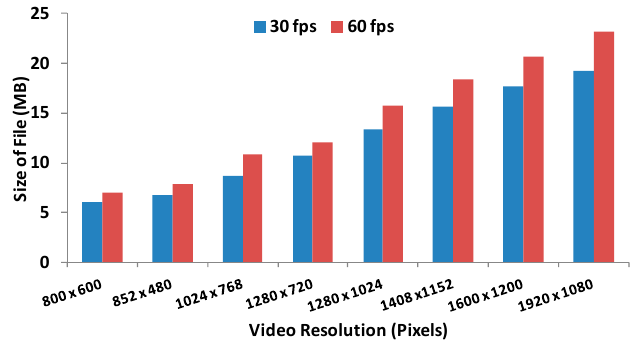
Figure 2. Size of files in MB.